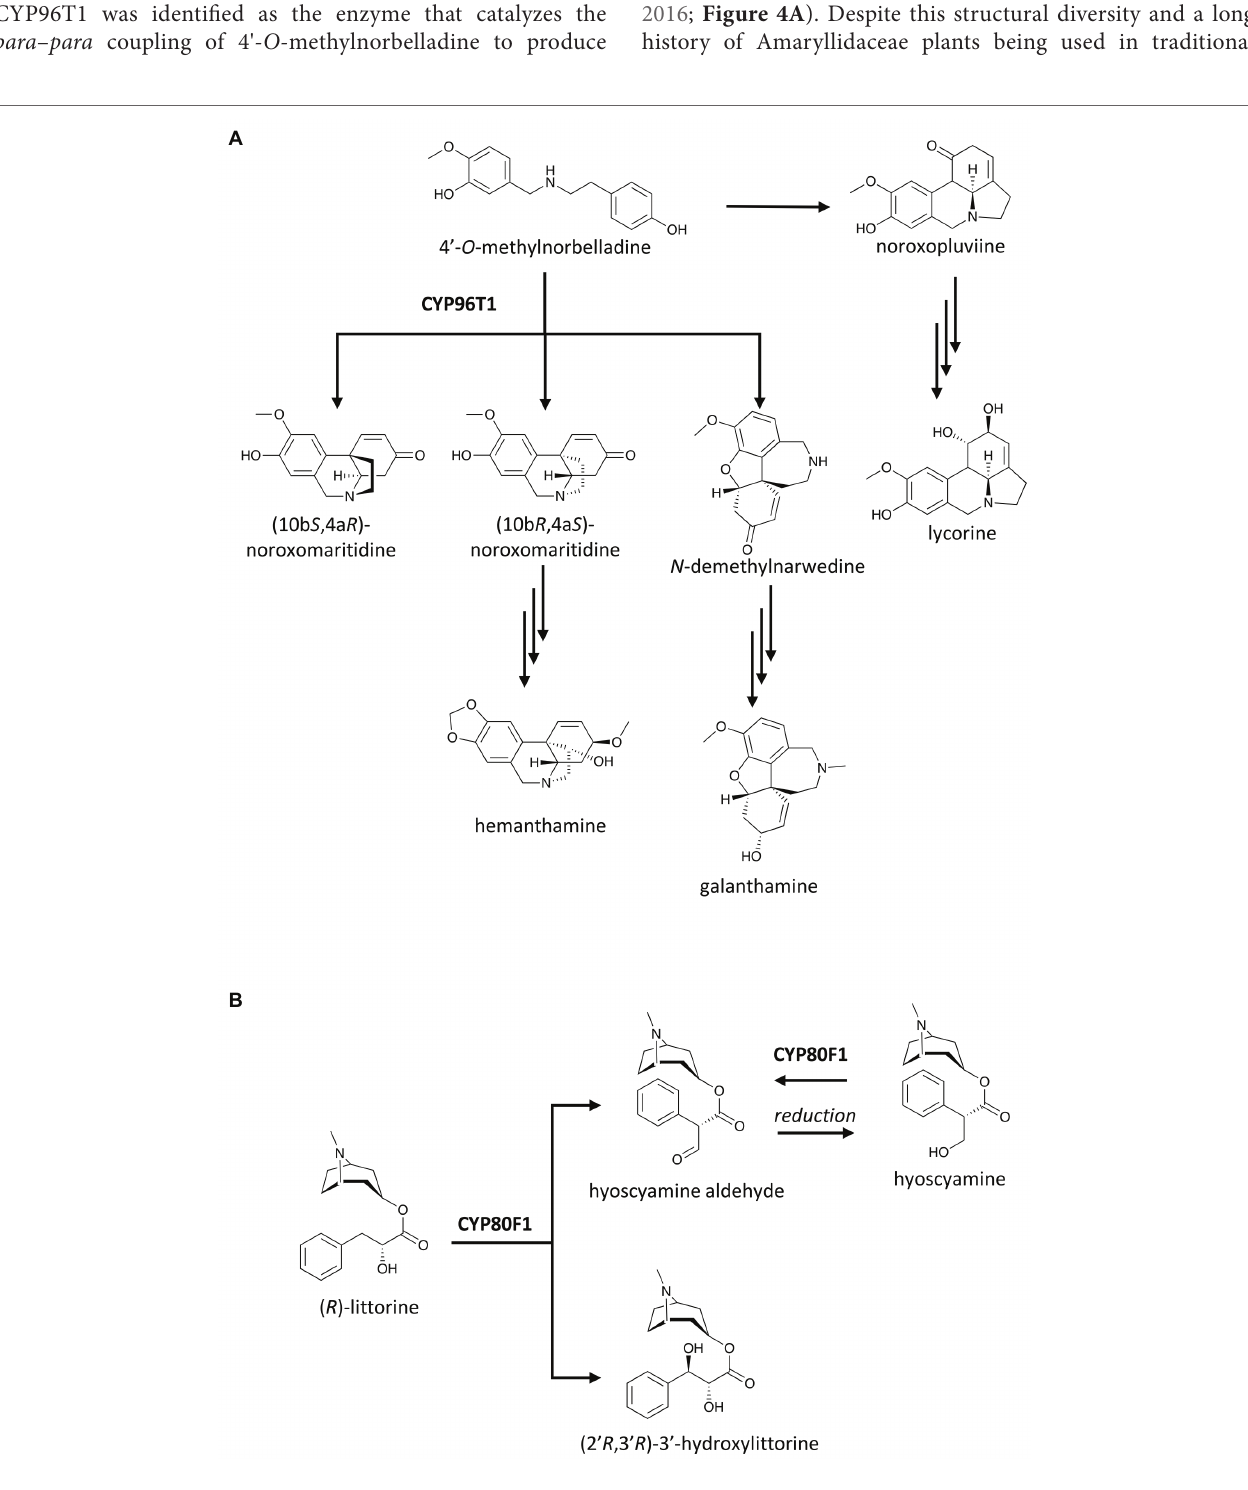
FIGURE 4 | Examples of P450 catalysis beyond oxygenation including: (A) C–C couplings of 4 ' - O -methylnorbelladine, a central precursor of Amaryllidaceae alkaloids, leading to various pathways; and (B) group migration in tropane alkaloid biosynthesis. Enzymes indicated here are discussed in the